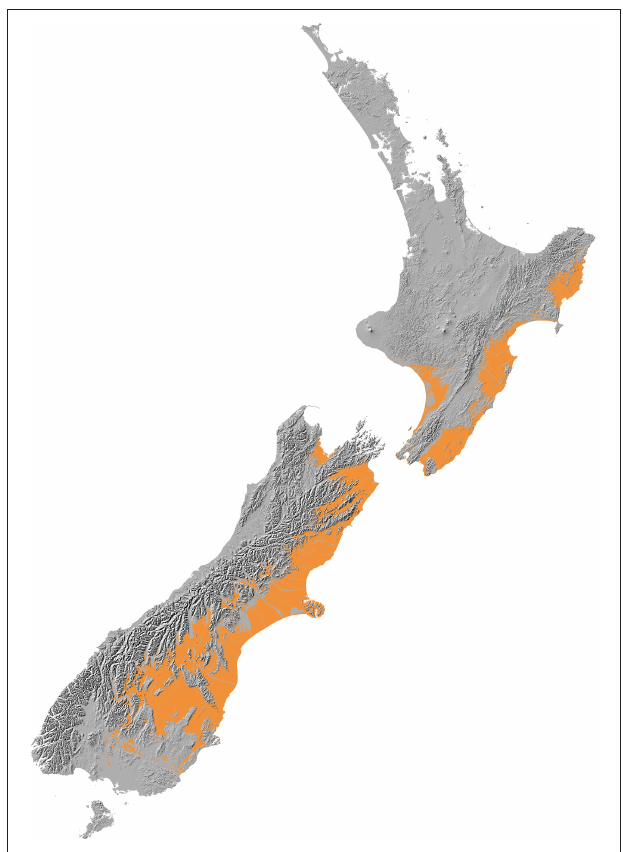
FIGURE 10 | Dryland zone. Modified from Walker et al. (2009). Baseline data held by Landcare Research.